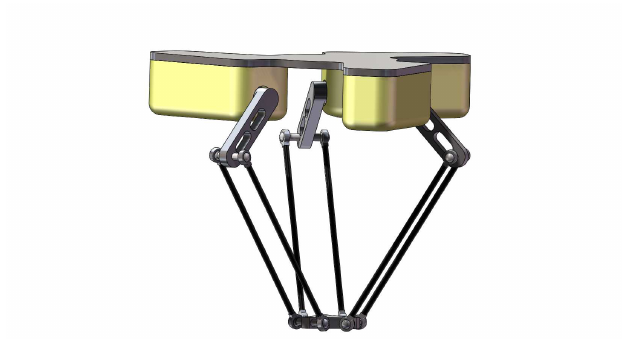
Figure 1. Schematic of a Delta robot.